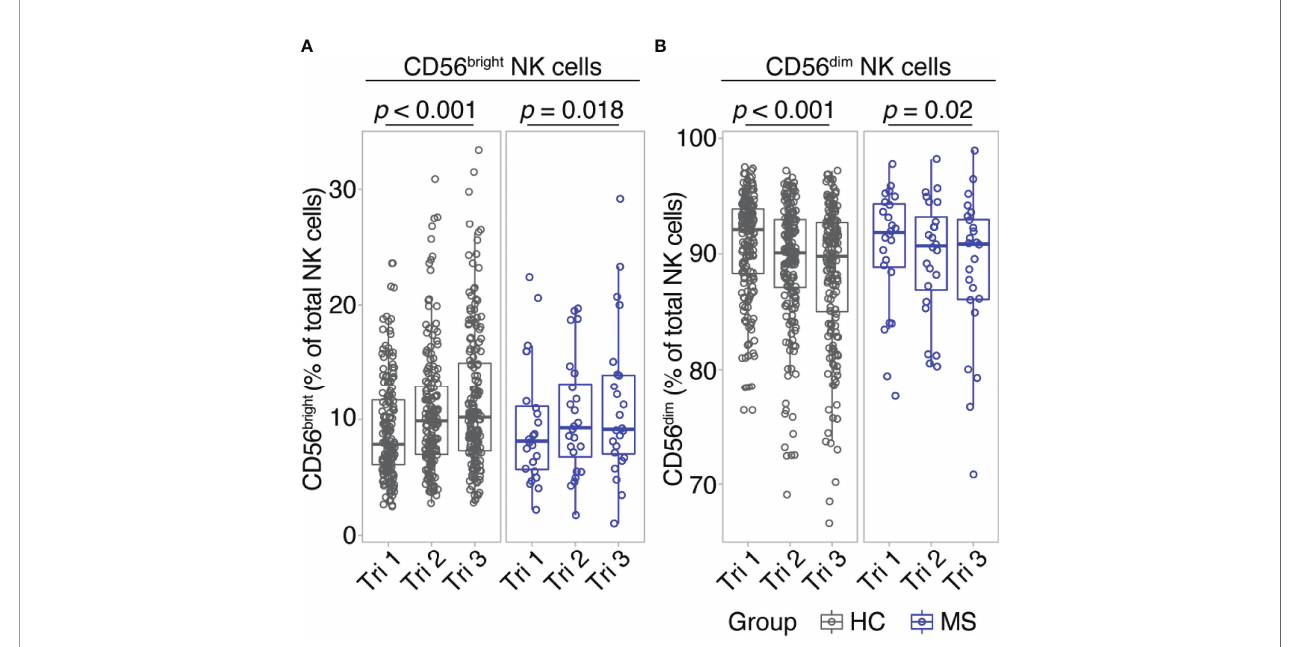
FIGURE 1 | CD56bright NK cells increase throughout pregnancy. Frequency of CD56 bright NK cells (A) and CD56 dim NK cells (B) in healthy pregnant women (HC, gray) and pregnant MS patients (MS, blue, Hamburg cohort) shown for each trimester of gestation. Boxplots depict median and inter-quartile range, overlaid with datapoints of individuals. Statistical analysis performed by Wilcoxon paired test between trimesters 1 and